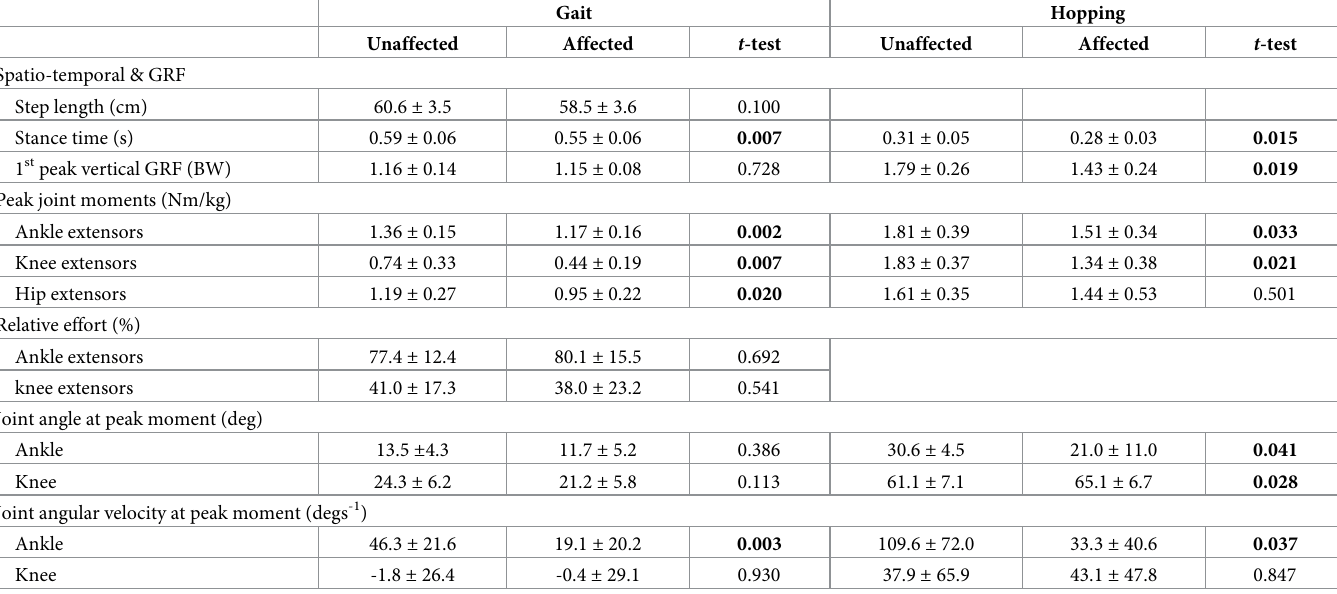
Table 1. Comparisons of the spatio-temporal, kinematic and kinetic data across limbs during the gait and hopping